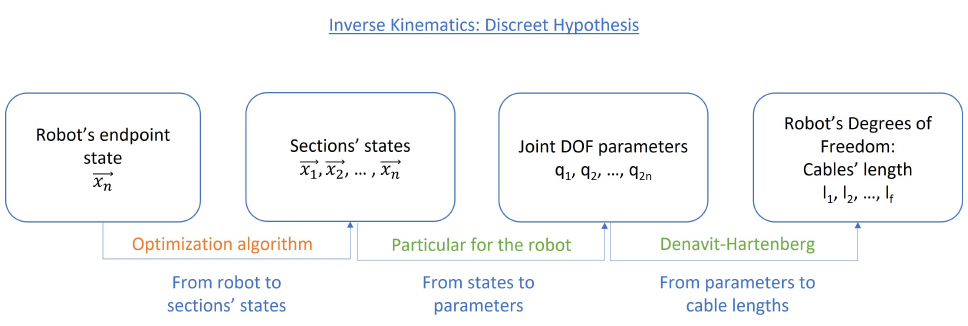
Figure 5. Inverse Kinematics for the discreet